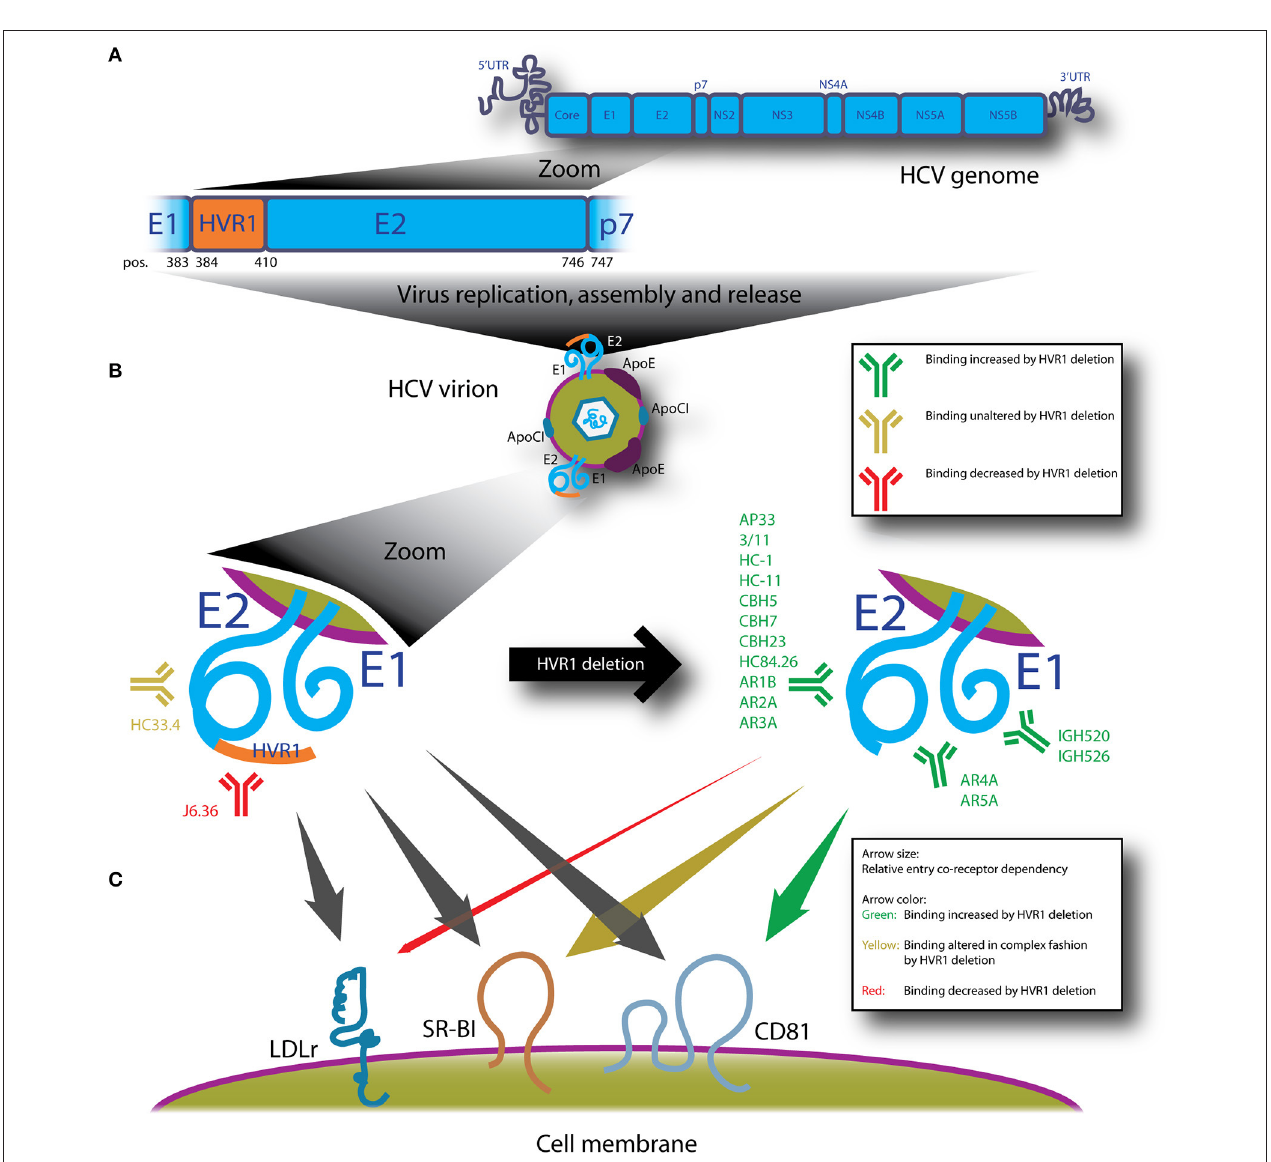
FIGURE 1 | HVR1 of HCV is located at the N-terminus of E2 and protects the virus from diverse neutralizing antibodies and modulates entry interactions with LDLr, SR-BI and CD81. (A) Depicts HCV genome organization with a zoom of E2 showing that HVR1 corresponds to the 27 N-terminal amino acids of E2 (H77 reference sequence; amino acid position 384–410). (B) Replication of the HCV genome in a permissive cell leads to assembly and release of HCV virions with the E1/E2 complex embedded in the viral envelope. For HVR1-deleted HCV, sensitivity to NAbs is dramatically altered as compiled from multiple studies referenced in the text